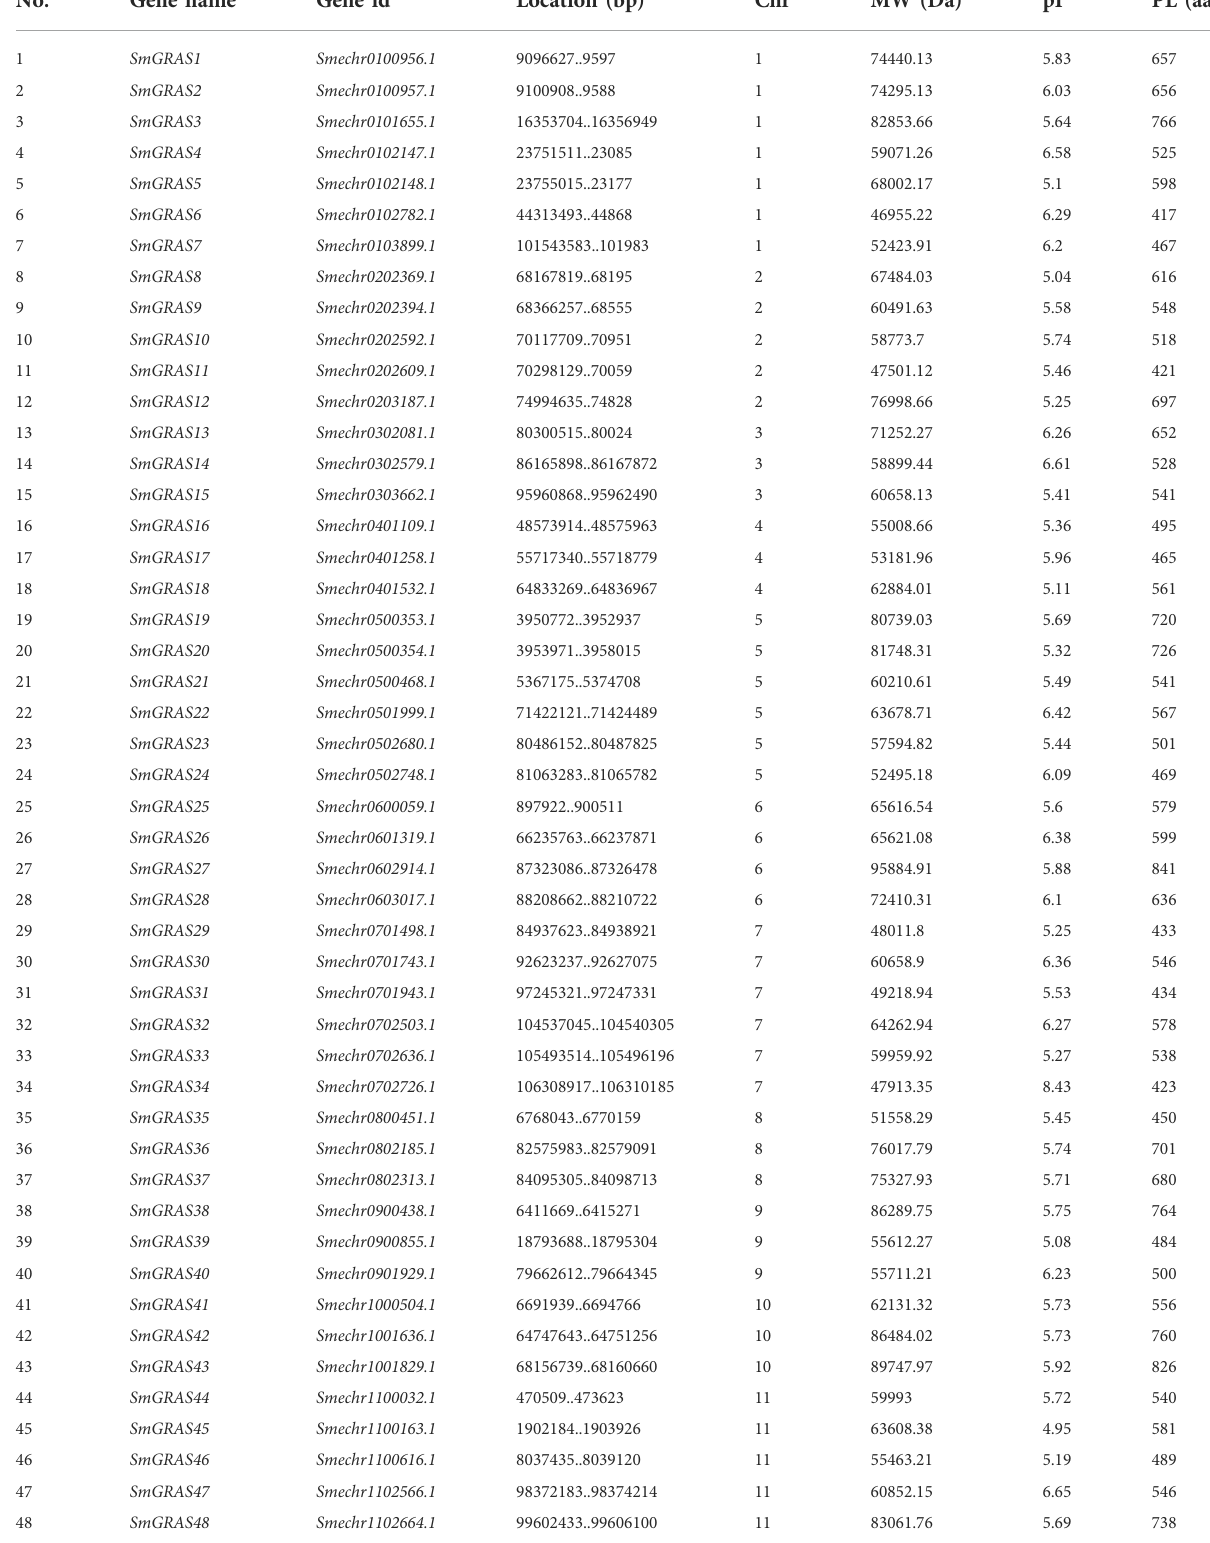
TABLE 1 GRAS genes identi fi ed in